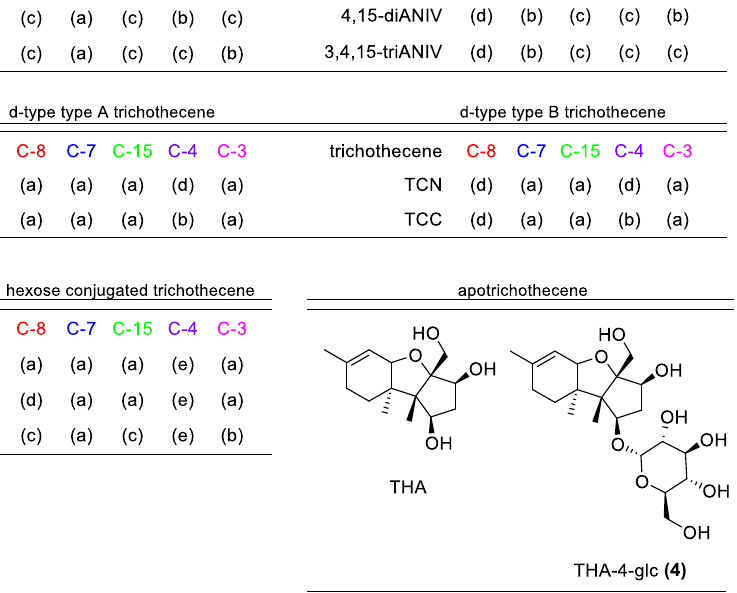
Figure 1. Chemical structures of trichothecenes and apotrichothecenes.